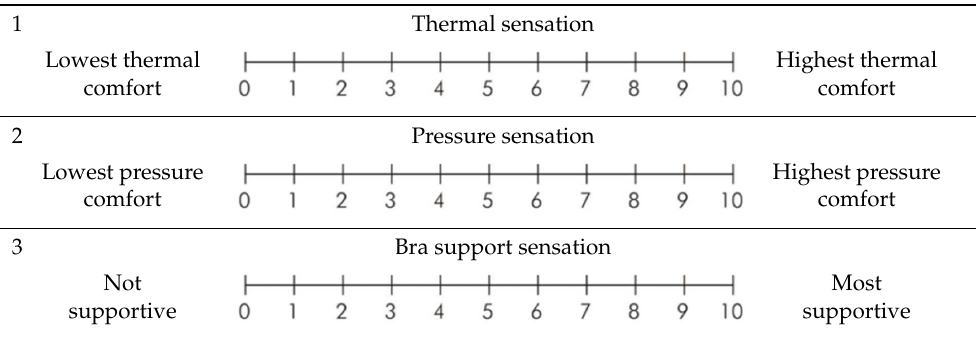
Table 2. Subjective sensation rating.